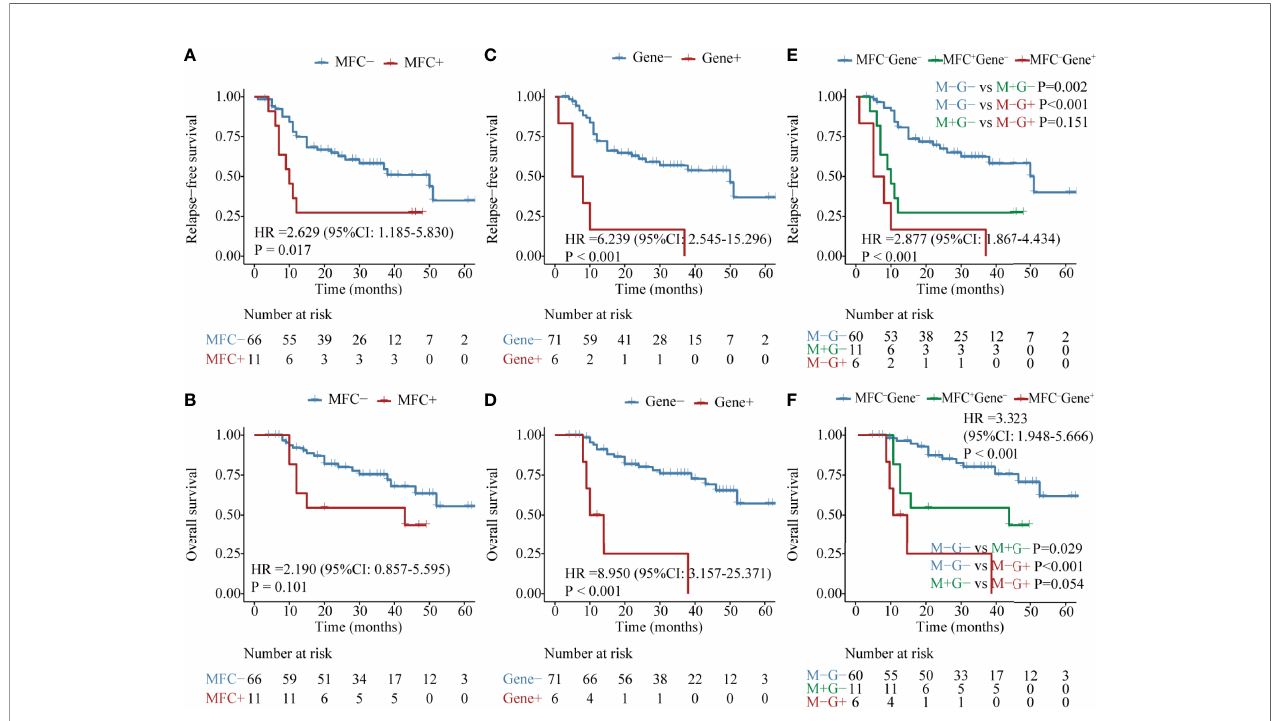
FIGURE 4 | Kaplan – Meier curves for probability of relapse-free survival (RFS) and overall survival (OS) in AML patients with kinase-related signaling pathway mutations. (A, B) RFS and OS based on MFC MRD status post two consolidation cycles. (C, D) RFS and OS based on FLT3 , C-KIT , or N-RAS mutations status by post two consolidation cycles. (E, F) RFS and OS based on MFC MRD status and Gene MRD status post two consolidation cycles.